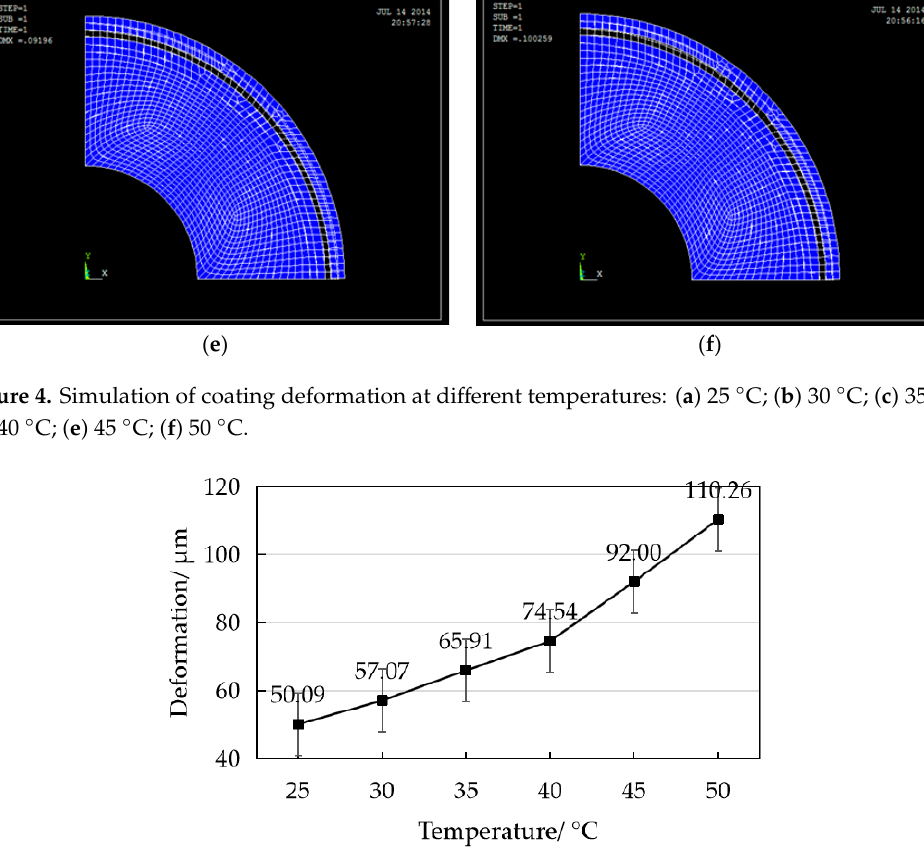
Figure 5. Deformation of the electrode at different temperatures.